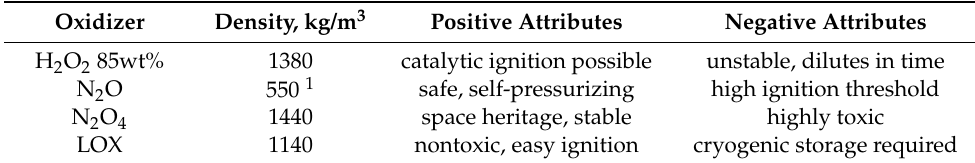
Table 1. Summary of oxidizer properties.